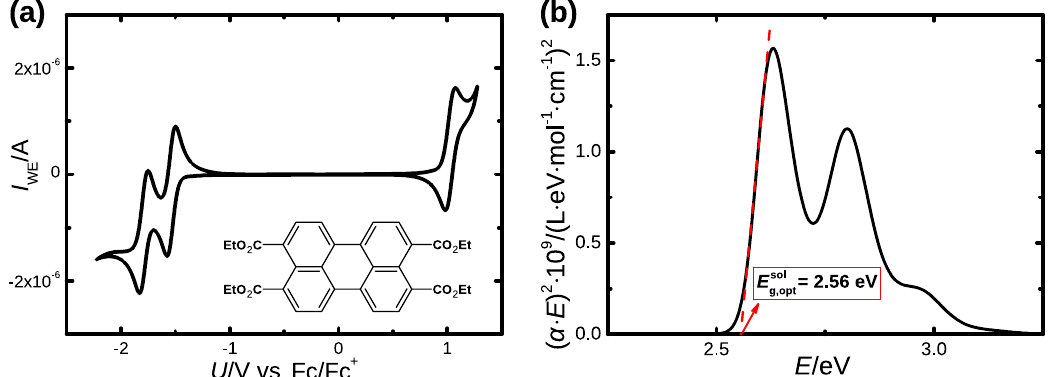
Figure 1. ( a ) Cyclic voltammogram of PTTE solved in CH 2 Cl 2 referenced to the internal standard Fc/Fc + . The inset shows the chemical structure of PTTE. ( b ) Tauc plot of PTTE in solution under the assumption of a direct allowed transition. The tangent of the low energy edge of the Tauc plot (red dashes) yields the value for the optical bandgap when it crosses the abscissa ( E sol g,opt = 2.56 eV).